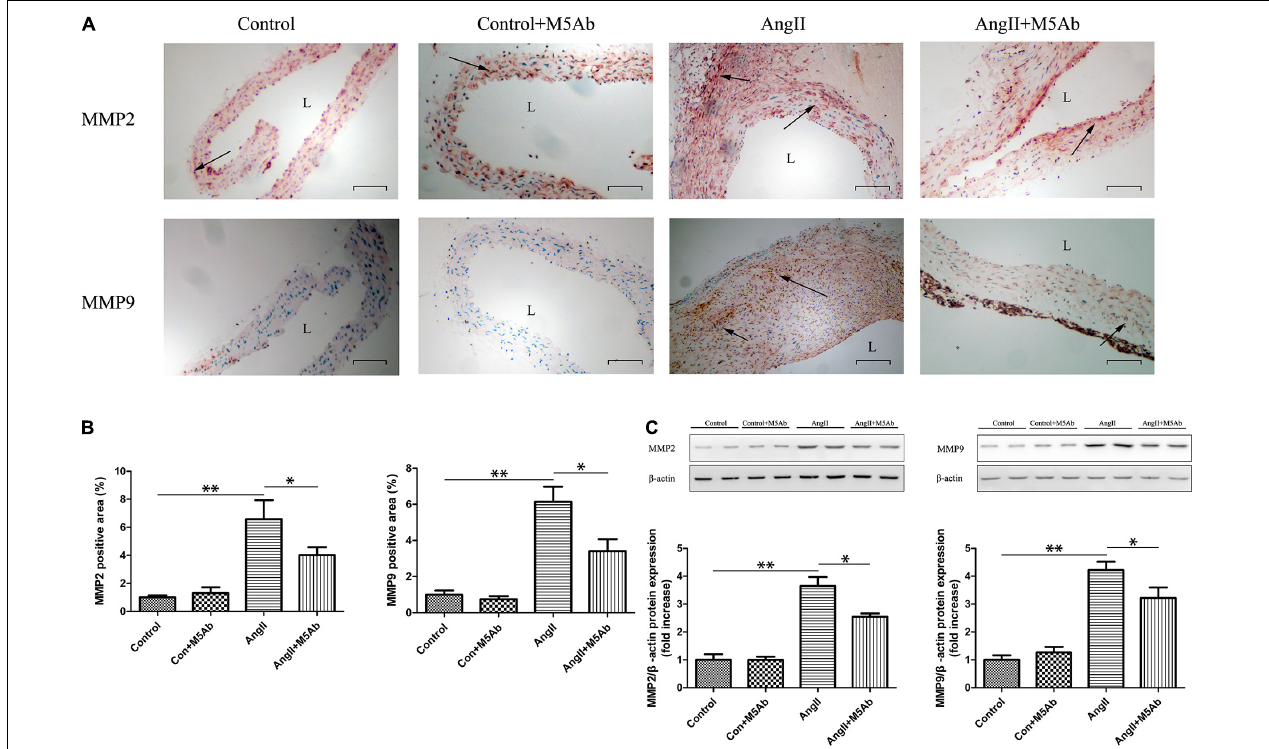
FIGURE 6 | M5Ab inhibits MMP2 and MMP9 expression in mice by blocking the expression of OPN-N. (A,B) Immunohistochemistry staining of MMP2 and MMP9 in mice under different treatments (A) , quantification of MMP2 and MMP9 area (B) . Scar bar 100 µ m. (C) Western blotting analyses the protein levels of MMP2 and MMP9 in mice, and quantification of MMP2 and MMP9 protein expression. β -actin was used as an internal control. Data are expressed as means ± SEM; n = 3 per group. ∗ P < 0.05 vs the Ang II + M5Ab group; ∗∗ P < 0.05 vs the control and control + M5Ab groups. Abbreviations: Ang II, angiotensin II; MMP, matrix metalloproteinase; and L,